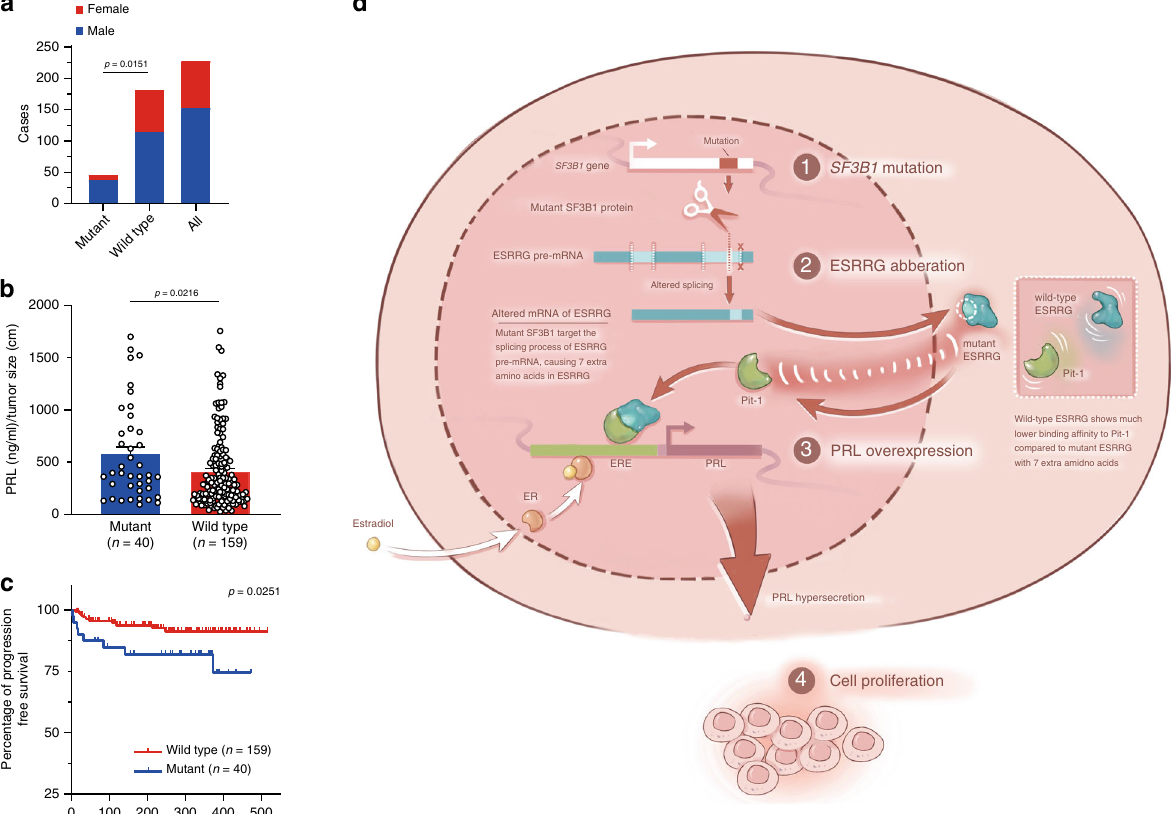
Fig. 7 Clinical relevance of the SF3B1 mutation. a The gender distribution is shown within different groups (mutant group n = 45 and wild group n = 182). b The PRL level (PRL/tumor size) in SF3B1 mutant and SF3B1 wild-type prolactinomas are displayed (mutant group n = 40 and wild group n = 159). Results are given as mean ± SD. c Kaplan – Meier survival plots of 199 prolactinomas patients strati fi ed by SF3B1 mutation status (mutant group n = 40 and wild group n = 159). d Schematic representation showing the proposed mechanisms of how SF3B1 mutations lead to increased PRL secretion and tumor growth in prolactinomas. The p values by chi-square test in a and by two-tailed Mann – Whitney test in b are indicated. The p value by log-rank (Mantel – Cox) test is indicated in c . Source data are provided as a Source Data fi le.